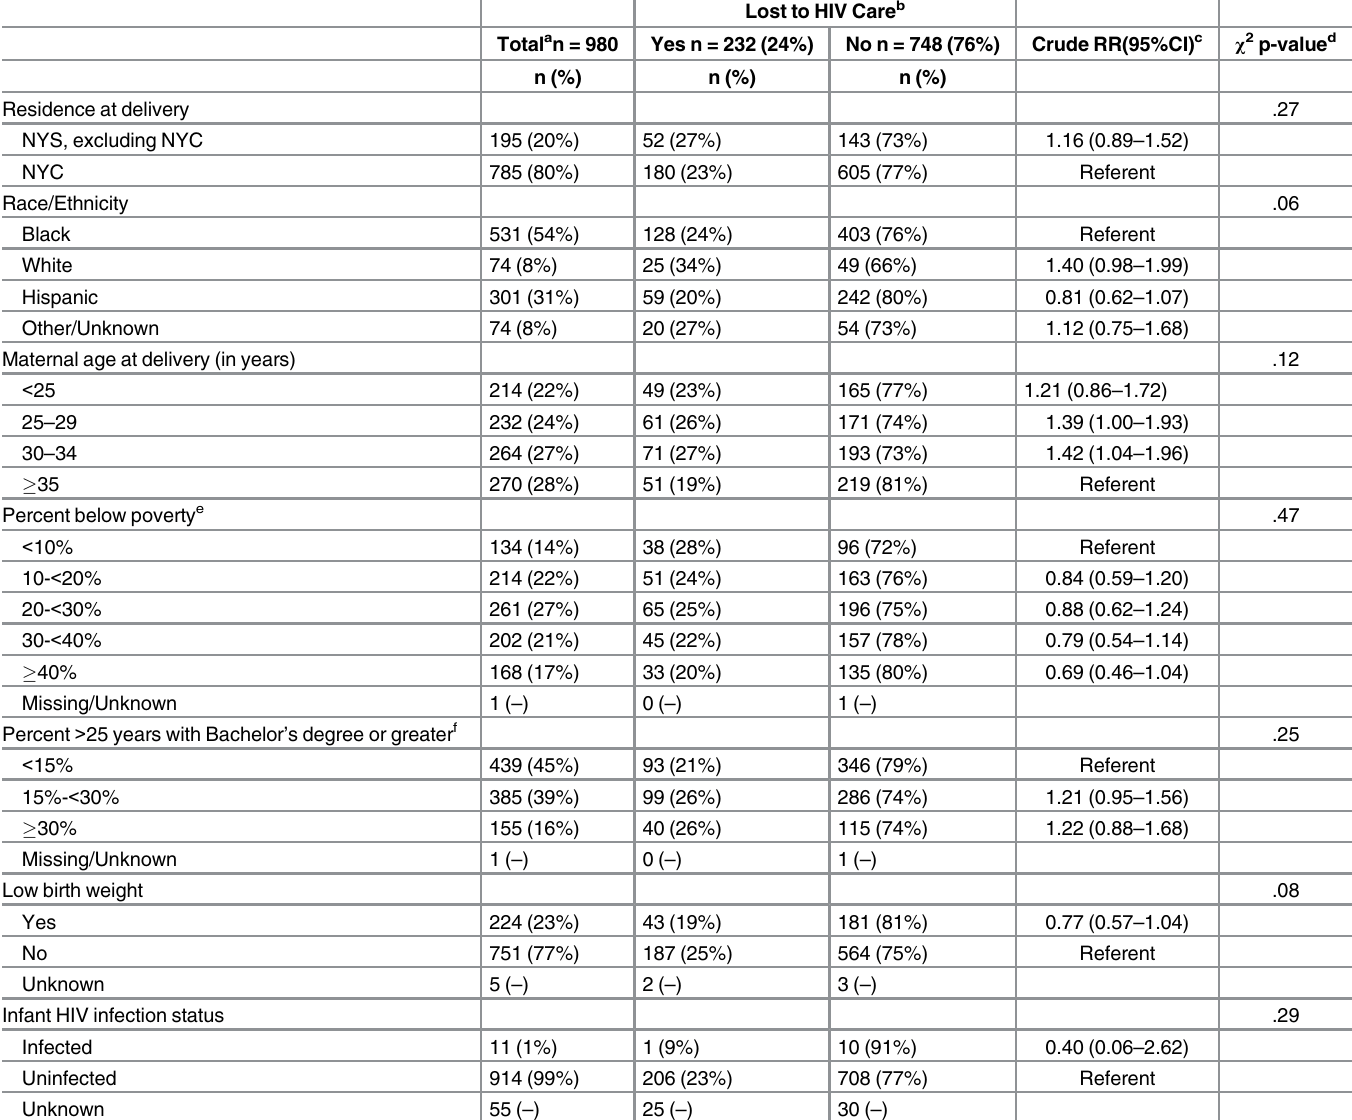
Table 1. Socio-Demographic Characteristics and Lost to HIV Care in the Postpartum Year among HIV-Infected Women with a Live Birth, Diagnosed Before Pregnancy, New York State, 2008 –